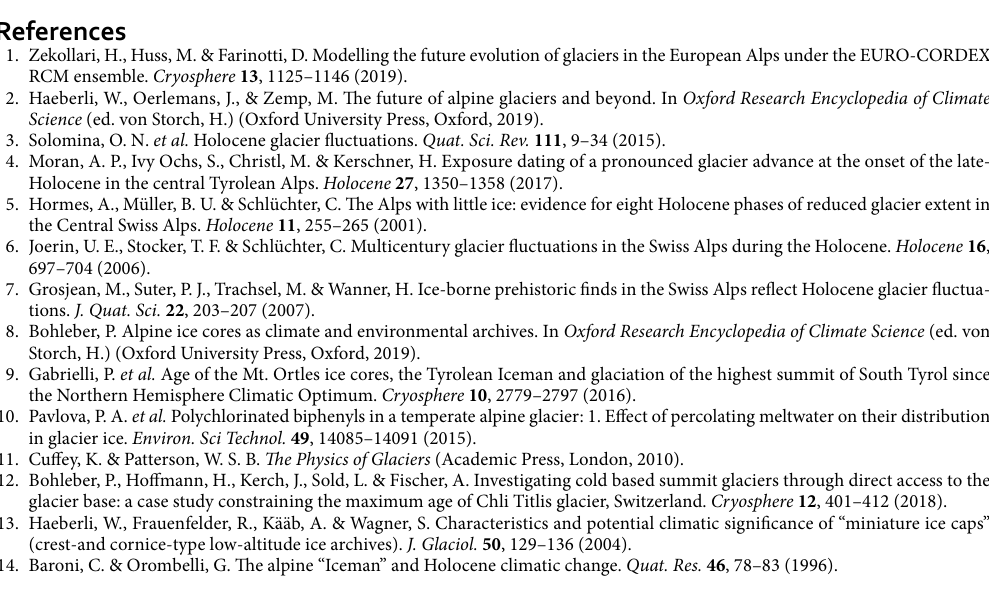
Table 4. Micro-radiocarbon dating results. a Due to visible silt material and high organic carbon content, the nominal age of the lowermost basal sample is biased by reservoir effects. It is reported for completeness but was not considered further for interpretation.